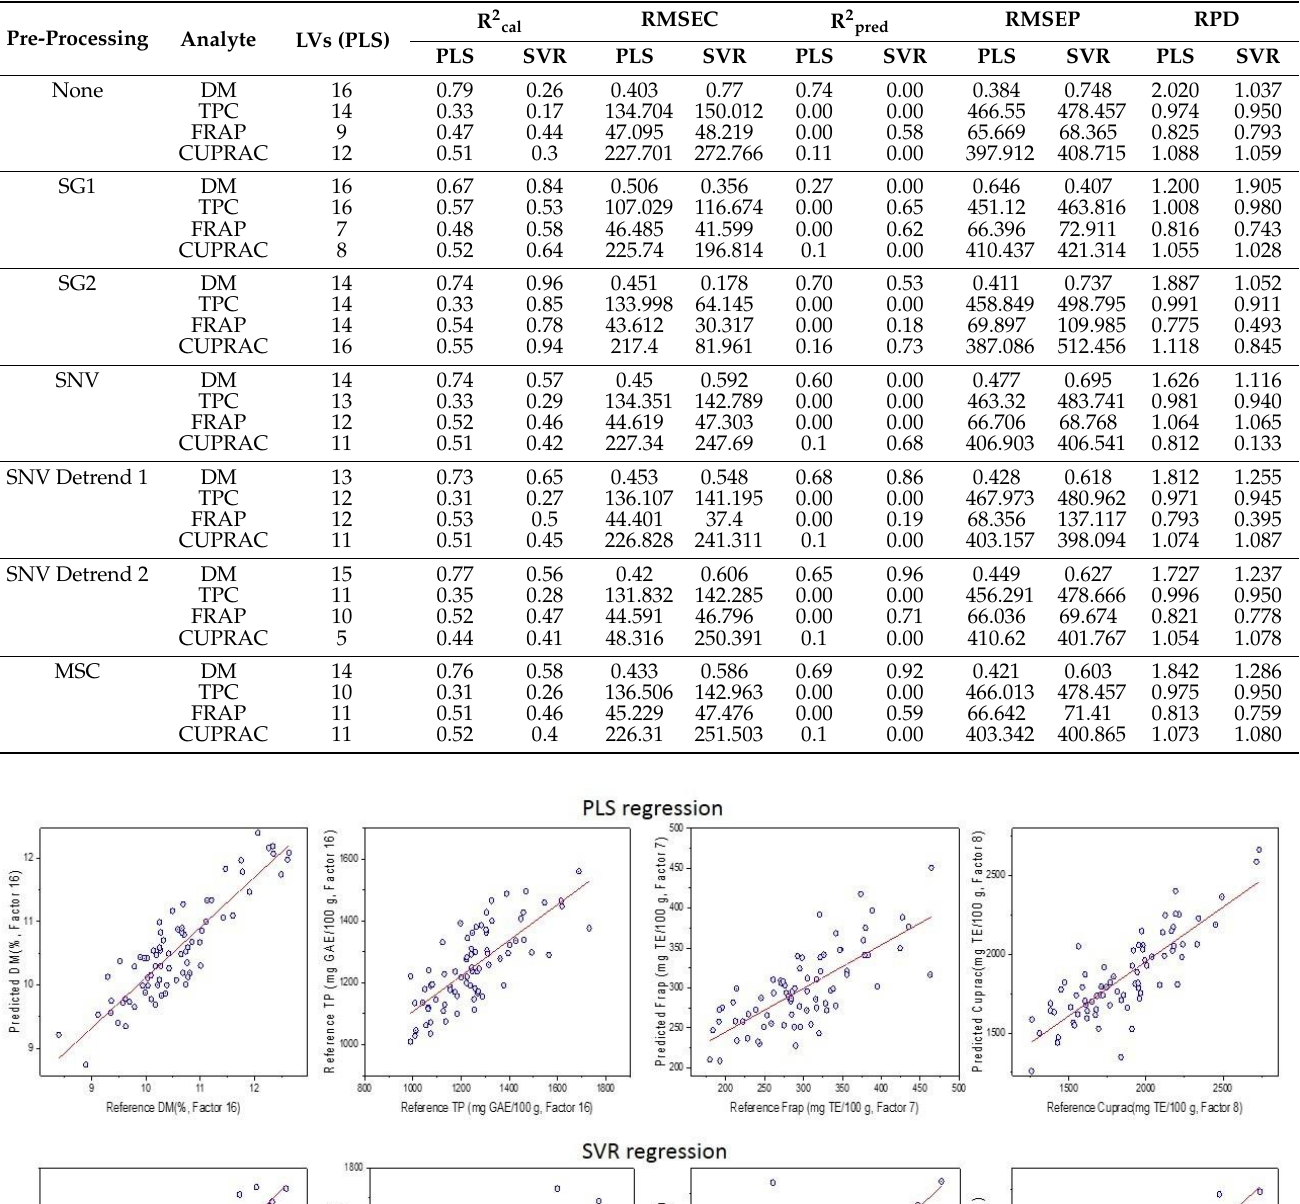
Table 3. Statistical parameters were obtained from the application of the PLSR and SVR algorithms on the NIR spectra dataset using different pre-processing methods.